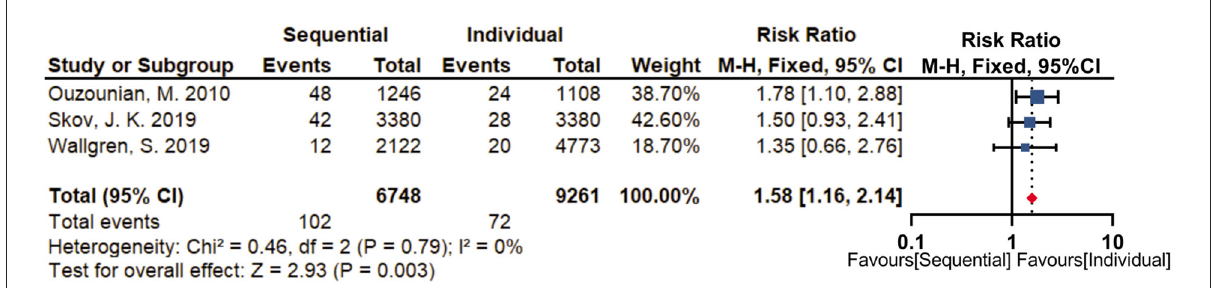
FIGURE5 Forest plot for perioperative repeat revascularization. Three studies reported perioperative repeat revascularization, revealing that sequential group (1.5%) was associated with a significantly higher risk of perioperative repeat revascularization (RR = 1.58; 95% CI, 1.16–2.14, P = 0.003) compared with individual group (0.7%).